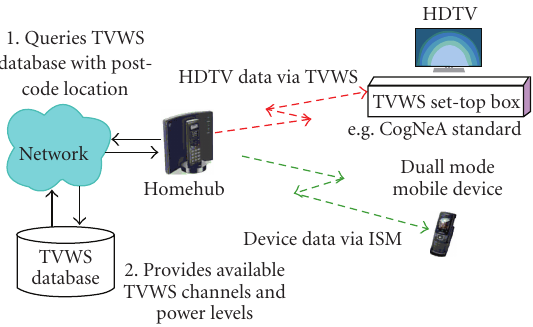
Figure 6: Architecture for HDTV distribution using TV White Space